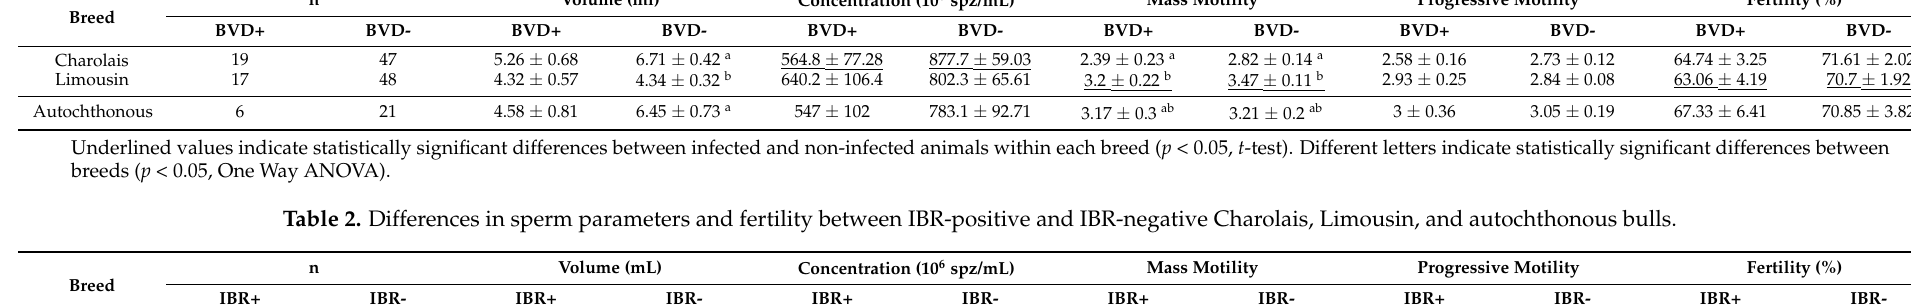
Table 2. Differences in sperm parameters and fertility between IBR-positive and IBR-negative Charolais, Limousin, and autochthonous bulls.